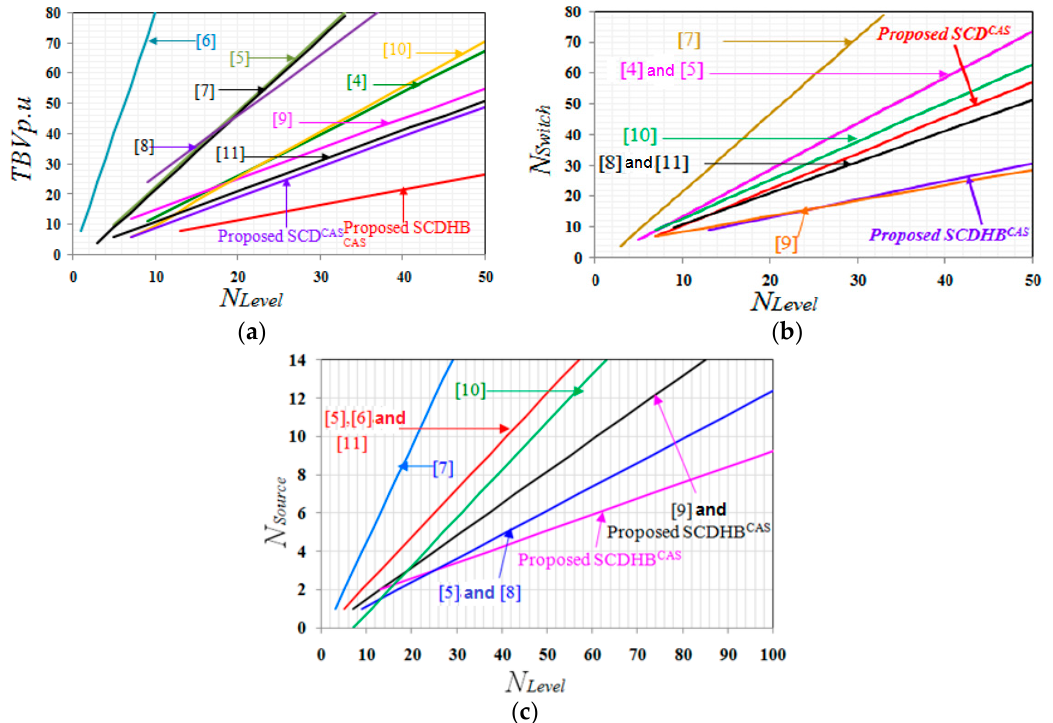
Figure 4. Comparison of proposed multilevel converter with other topologies ( a ) N Switches vs. N Level ; ( b ) TBVp.u vs. N Level and ( c ) N Level vs. N source